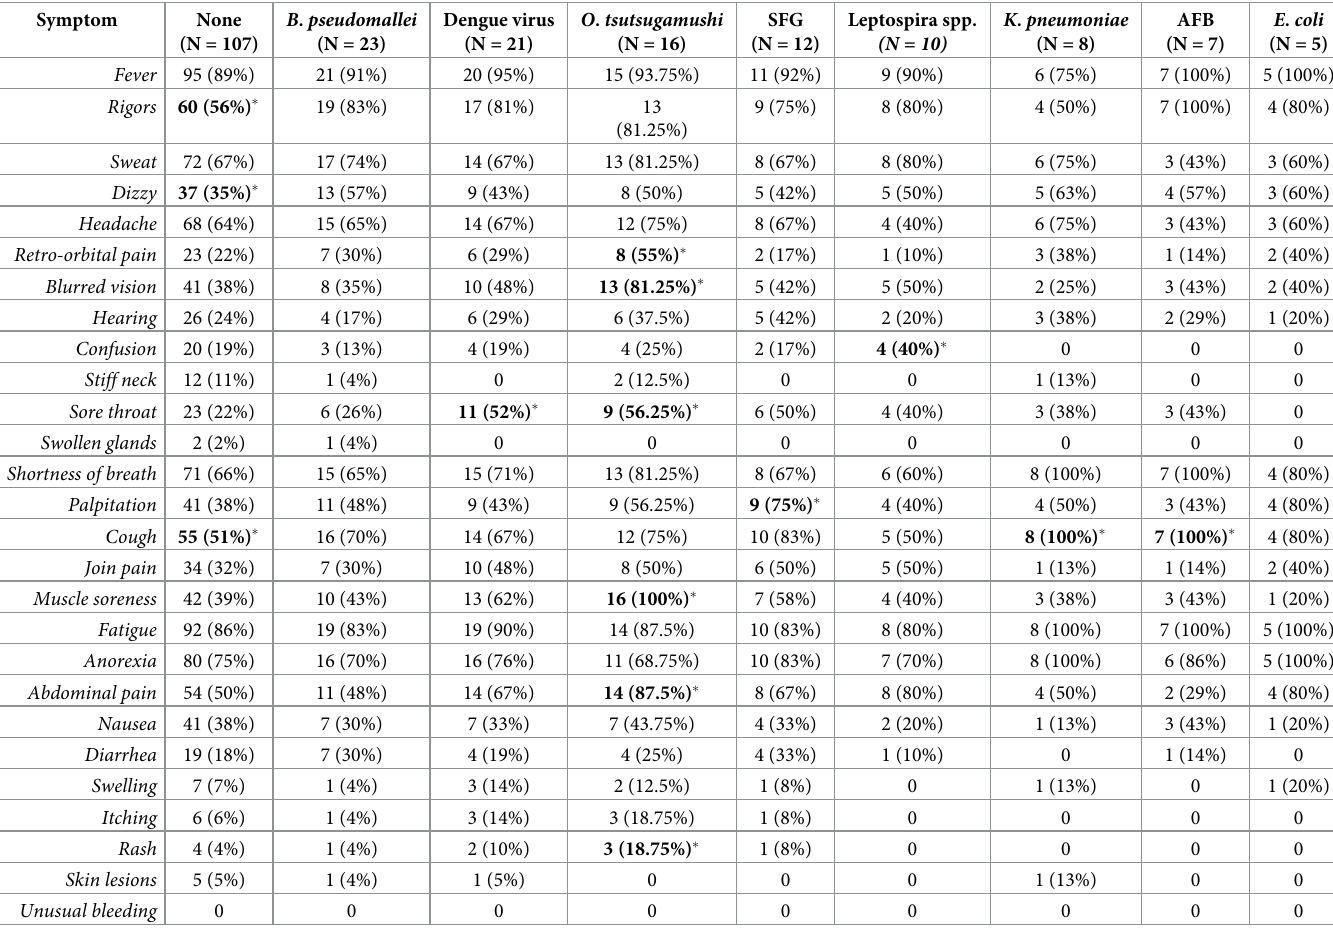
Table 4. Clinical symptoms associated with pathogens. Complaints of symptoms prior to hospitalization collected during enrollment. Bolded value with asterisk indi- cates the value is significantly different from patients without the indicated pathogen. Clinical symptoms were compared for patients with different infectious etiologies as described above. All tests of statistical significance were two-tailed, and significance was defined as p <